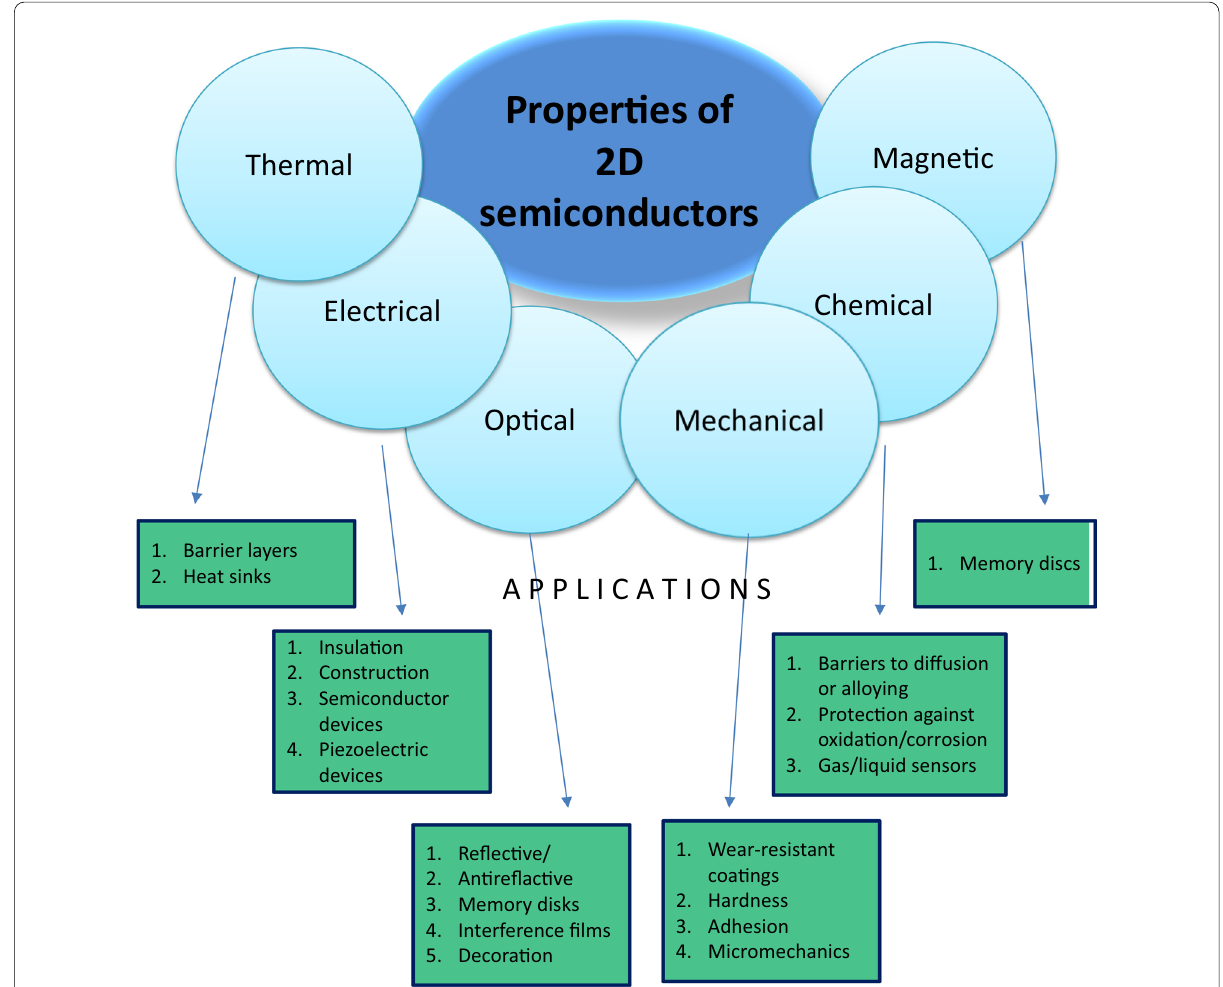
Fig. 2 Properties of 2D semiconductors utilized in their typical